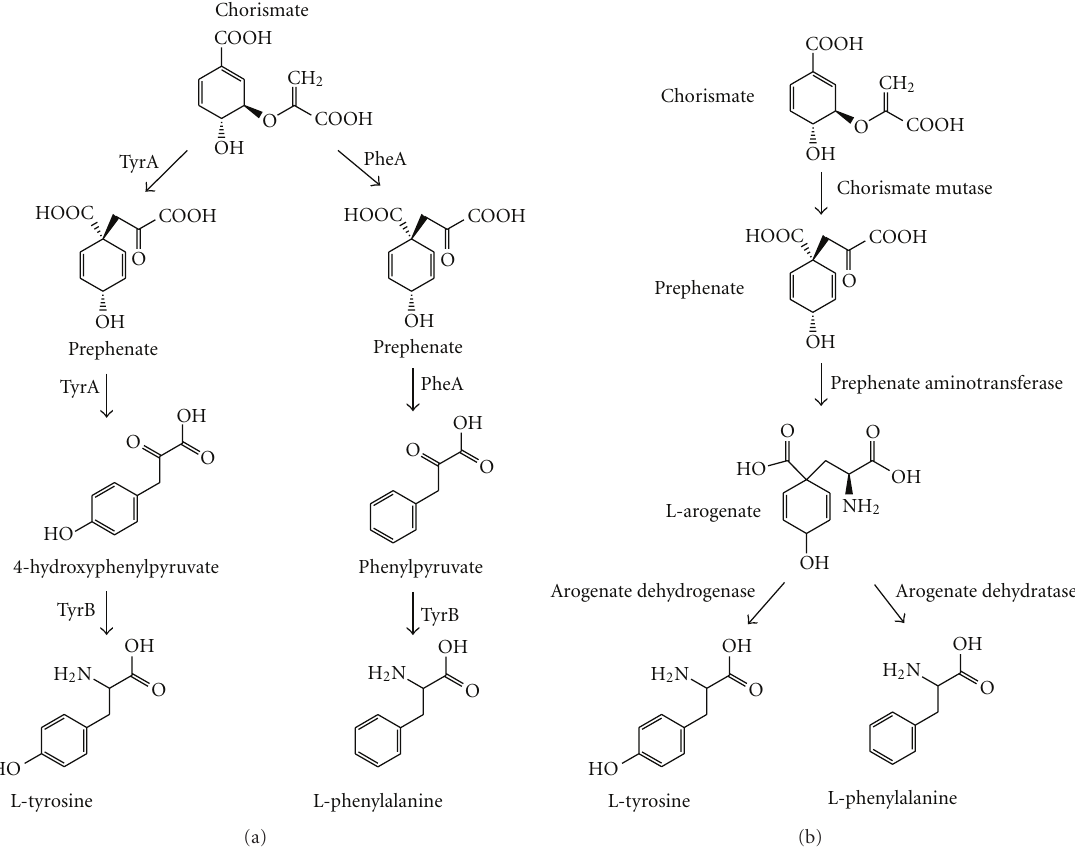
Figure 1: Pathways for L-Tyrosine and L-Phenylalanine biosynthesis in E. coli and plants. (a) shows the pathway for both amino acids from the intermediate chorismate in E. coli . Abbreviations in the diagram include PheA (chorismate mutase/prephenate dehydratase), TyrA (chorismate mutase, prephenate dehydrogenase), and TyrB (tyrosine aminotransferase). (b) depicts the plant pathway for the synthesis of the amino acids from the common intermediate